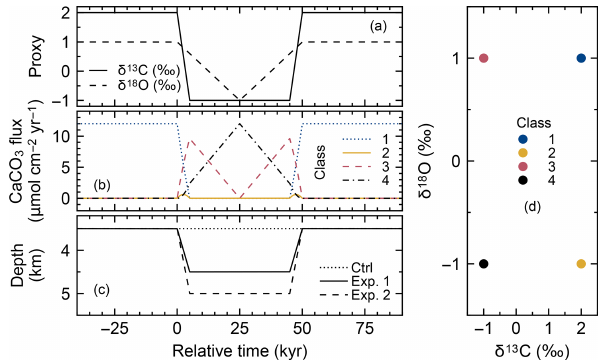
Figure 12. Timelines of proxy inputs (a) , rain fluxes of individual classes of CaCO 3 particles (b) with different proxy values (d) and water depth changes (c) in simulations examining signal distortion by CaCO 3 dissolution. Two different water depth changes are con- sidered, denoted as dissolution experiments 1 and 2 (c) . One set of experiments was conducted without changing the water depth for comparison (dotted line in c